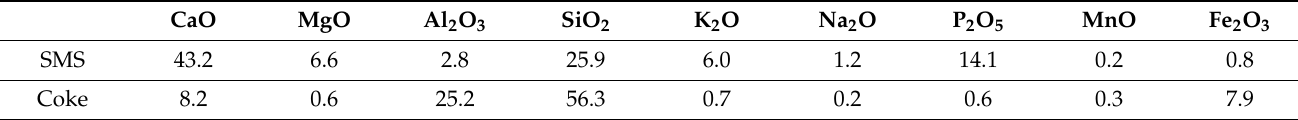
Table 2. Results of ash composition for SMS (mass %).